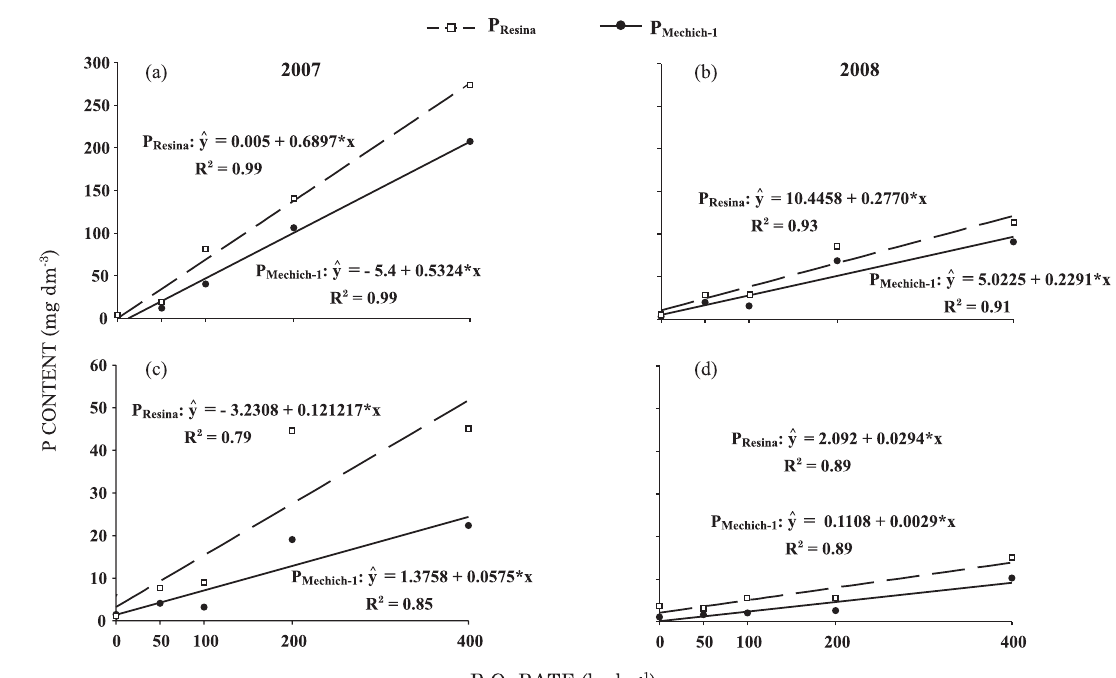
Figure 2. Contents of available phosphorus in the soil by Mehlich-1 and ion exchange resin extractors, in function of annual application of phosphorus rates, in samples collected in two years (a and b = depth of 0–10 cm; C and D depth of 10–20 cm). * Significant by t test at 5